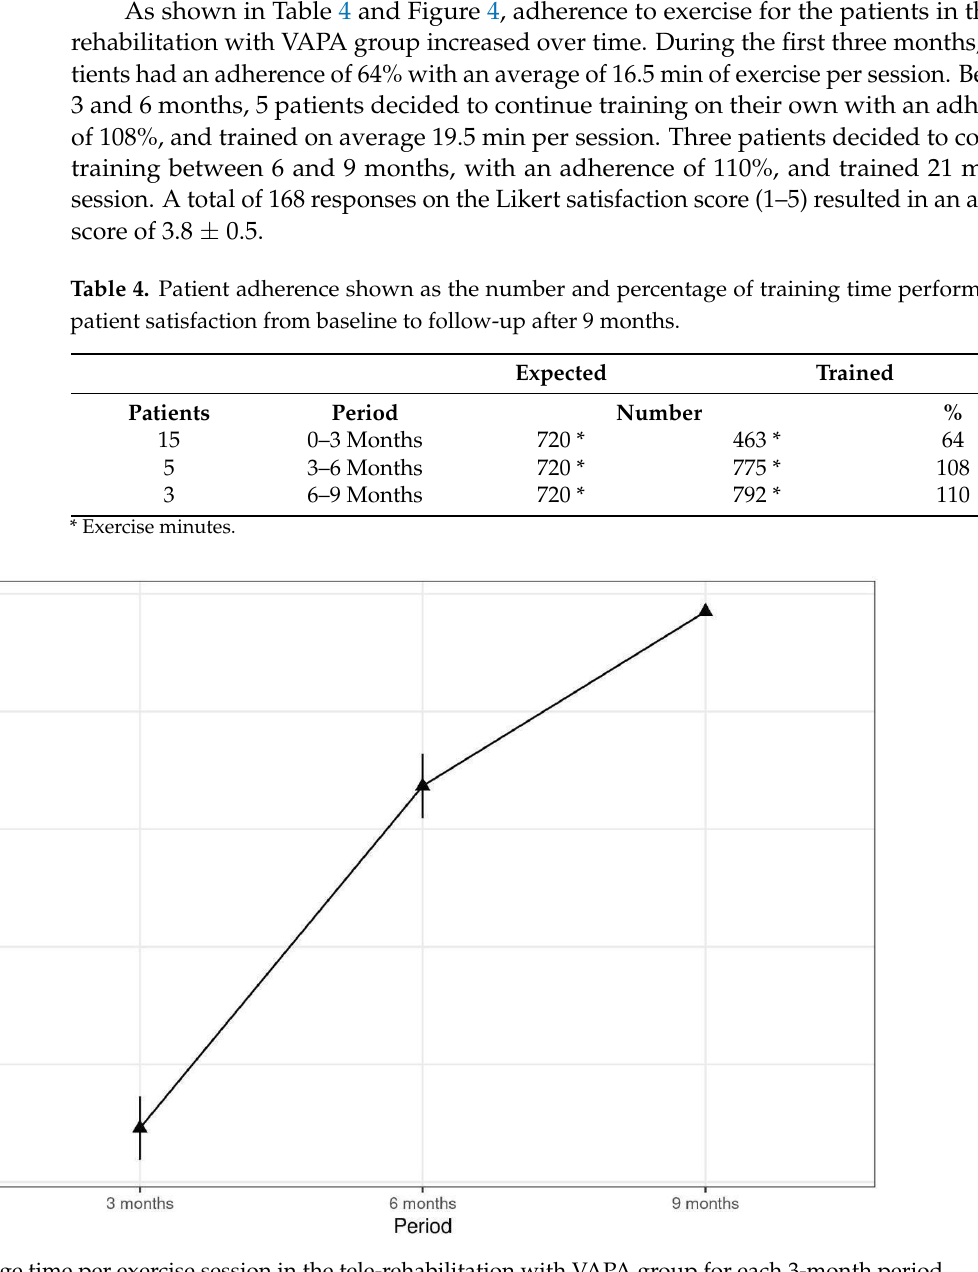
Figure 4. Average time per exercise session in the tele-rehabilitation with VAPA group for each 3-month period.